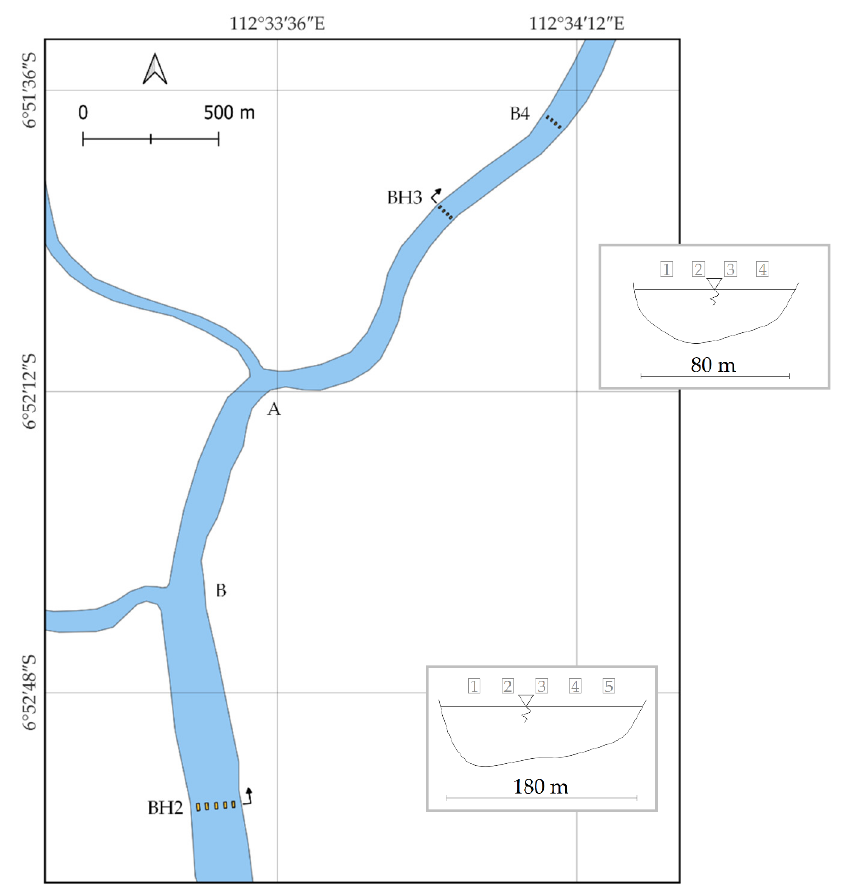
Figure 2. Column sampling of material on the river span.